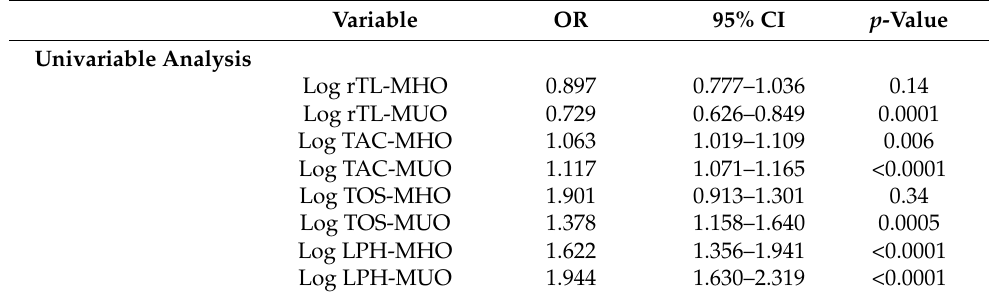
Table 5. Univariate analyses of the effects of oxidative stress markers on metabolic health status.